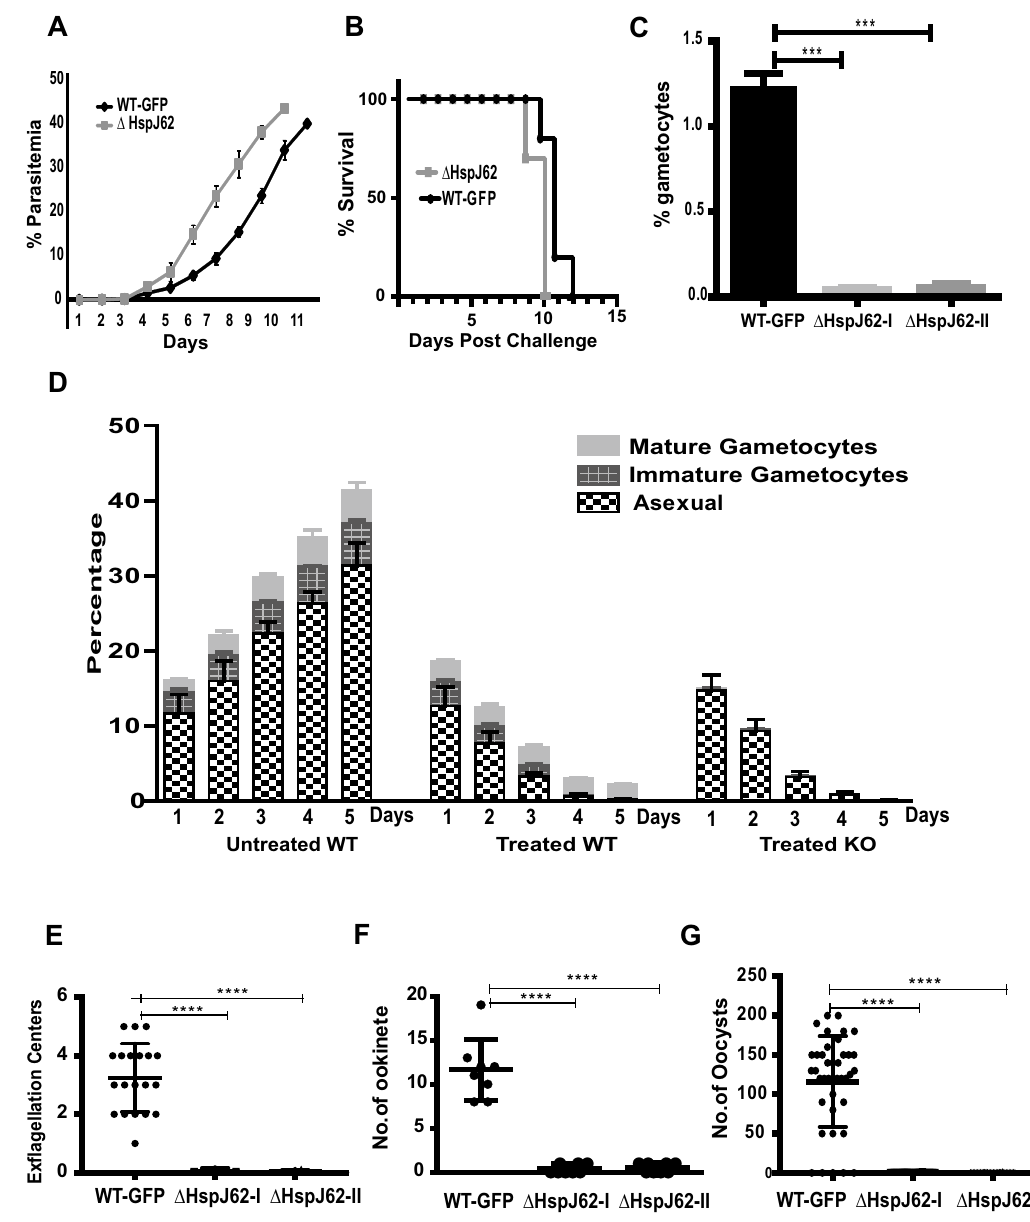
Figure 4. HspJ62 knockout parasites are unable to develop sexual stages. ( A ) The blood stage growth curves of the ΔHspJ62 parasite line in comparison with the wild-type strain are shown. Parasitemia was monitored daily from Day 1 until the mice died by Giemsa staining on slides, following intravenous injection of an equal number of WT or ΔHspJ62 parasites. ( B ) The survival of WT or ΔHspJ62 parasite-infected mice was counted and plotted. All data points are from one of the two representative experiments, showing the average daily parasitemia ± SD of groups of 10 mice each infected with WT or one of the two independent clones of ΔHspJ62 parasite ( A , B ). Gametocyte formation was monitored in wild-type and ΔHspJ62 parasites following intravenous injection of an equal number of WT or ΔHspJ62 parasites. ( C ) Gametocytemia was determined per 1000 red blood cells in Giemsa-stained blood smears. The graph shows the percent gametocytes formed in the clonal ΔHspJ62 parasite line in comparison with the wild-type strain; the error bars represent the mean and SD from three independent biological experiments conducted in triplicate. ***P < 0.0002, using one way ANOVA-Kruskal–Wallis test. ( D ) The effect of chloroquine (10 mg/ml) on WT and two independent clones of ΔHspJ62 parasite lines. ( E ) Exflagellation center formation was examined 5 min after activation of iRBCs collected from mice infected with WT-GFP or ΔHspJ62 parasites at day 4 post infection. The number of exflagellation centers was calculated from the number of actively moving gametes interacting with neighboring RBCs in 1000 RBCs. ( F ) The zygote/ookinete conversion rate is the percentage of female sexual stage parasites developing into zygotes or ookinetes. The zygote/ookinete conversion rate is generally calculated as the number of zygotes/ ookinetes divided by the total number of female gametocytes. Since no male/female gametocytes were observed in ΔHspJ62 parasites, we looked for the formation of ookinetes per 10,000 RBCs. The number of ookinetes formed in WT and two independent clones of ΔHspJ62 parasites was calculated and plotted. ( G ) Oocyst formation and numbers were observed and counted in the mosquito midgut 14 days after an infected blood meal. Statistical analysis was performed using one-way ANOVA ****P = 0.0001. The image is representative of one of the three replicates